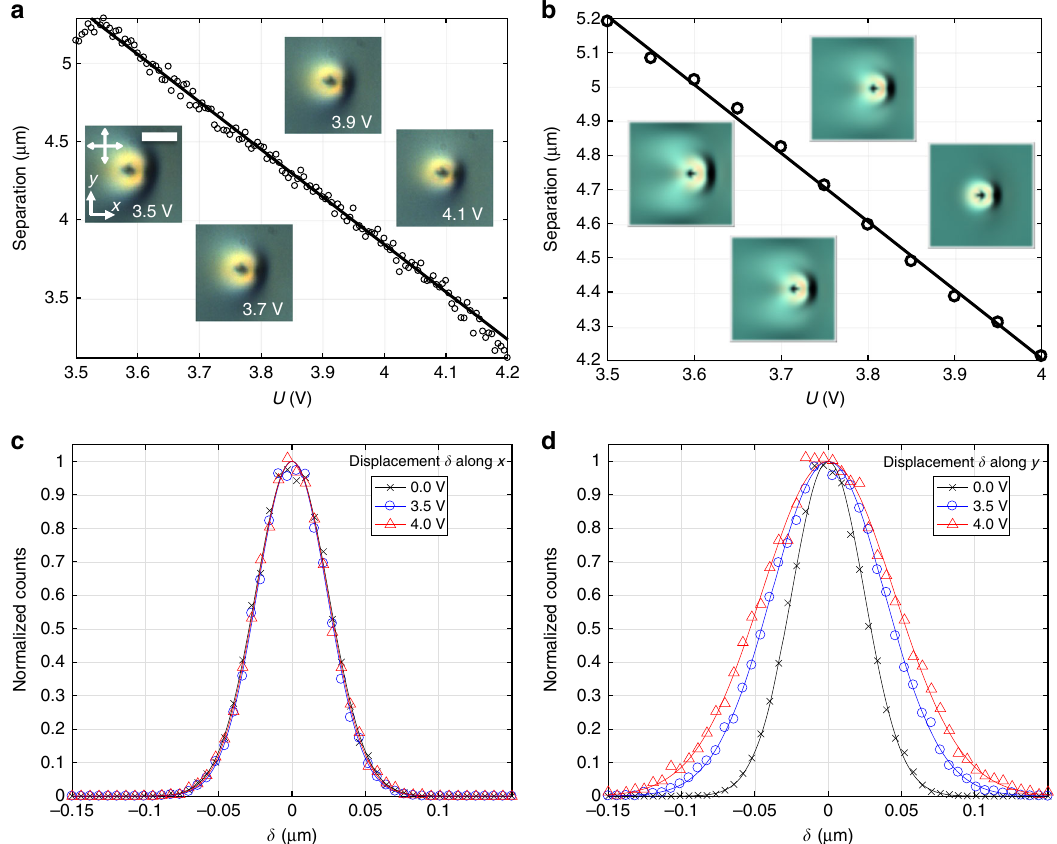
Fig. 5 Electric control and Brownian motion of baby skyrmions. a , b Lateral separation between north-pole (blue arrows in Fig. 2d – f) and south-pole (red arrows) preimages characterized ( a ) using POM videos and ( b ) computer simulations. Insets show experimental and computer-simulated POM micrographs at voltages and for crossed polarizers (white double arrows) marked in a . The scale bar in the insets is 10 µ m. f c = 1 kHz. c , d Histograms of displacement δ of the south-pole preimage characterizing Brownian motion of a baby skyrmions ( c ) along the x axis and ( d ) along the y axis at different U ; the solid lines are Gaussian fi ts of the experimental data points (symbols)